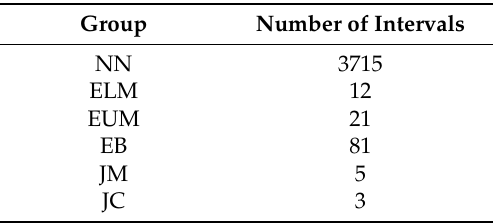
Table 1. Number of intervals per group using the SM . The groups are None (NN), Jaw Clench (JC), Jaw Movement (JM), Eye Blink (EB), Eye Left Movement (ELM), and Eye Up Movement